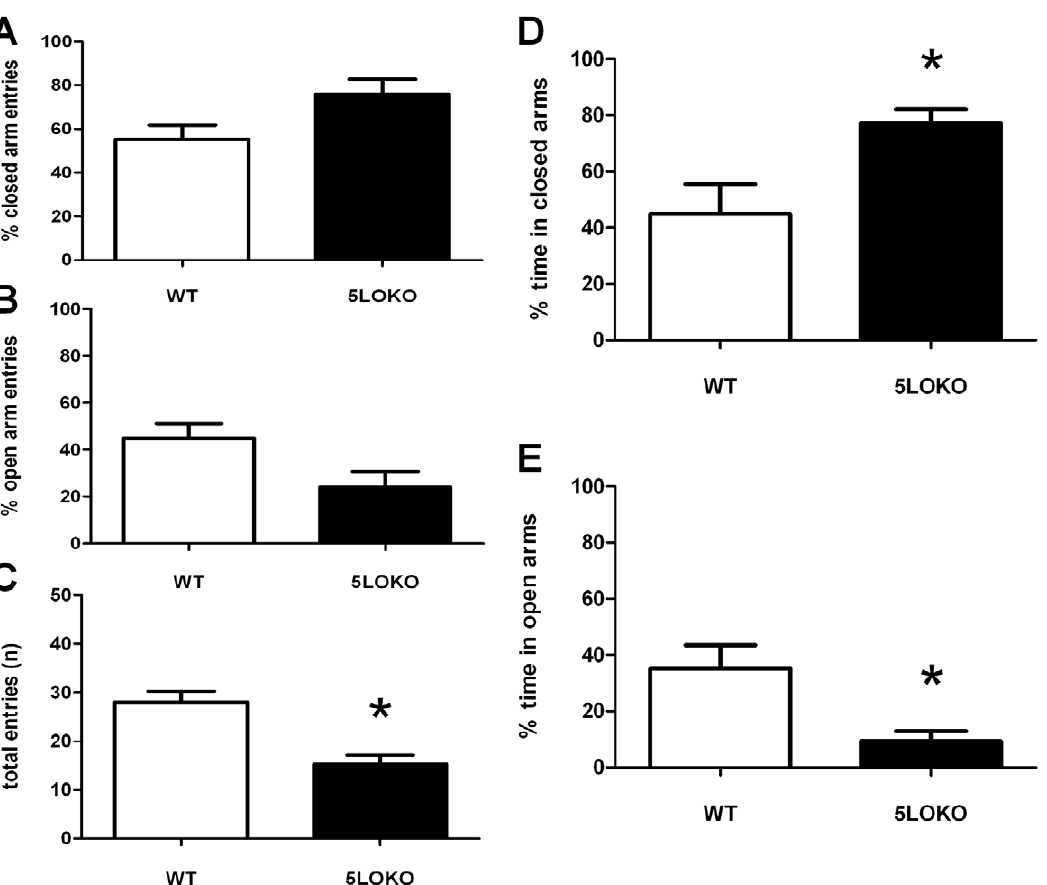
Figure 2. Elevated plus maze behavior in 6 mo old mice. Percentage of total entries into the closed arm (A), open arm (B), total arm entries (C) and percentage of total time spent in closed (D) and open arm (E). 5LO-KO mice (closed bars) spent more time in the closed arm and less time in the open arm than wild type (WT) mice (open bars). 5LO-KO animals also entered less total arms than WT. (WT, n=4; 5LO-KO, n=4; P , 0.05).